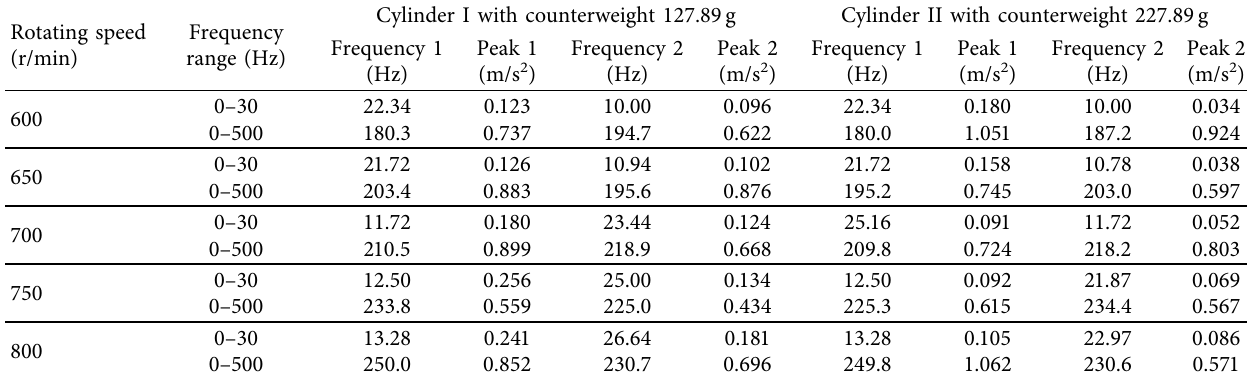
Table 4: FFTmain data of vibration acceleration of three-cylinder unilateral drive cylinder I in the horizontal position of the bearing seat in the Y direction.